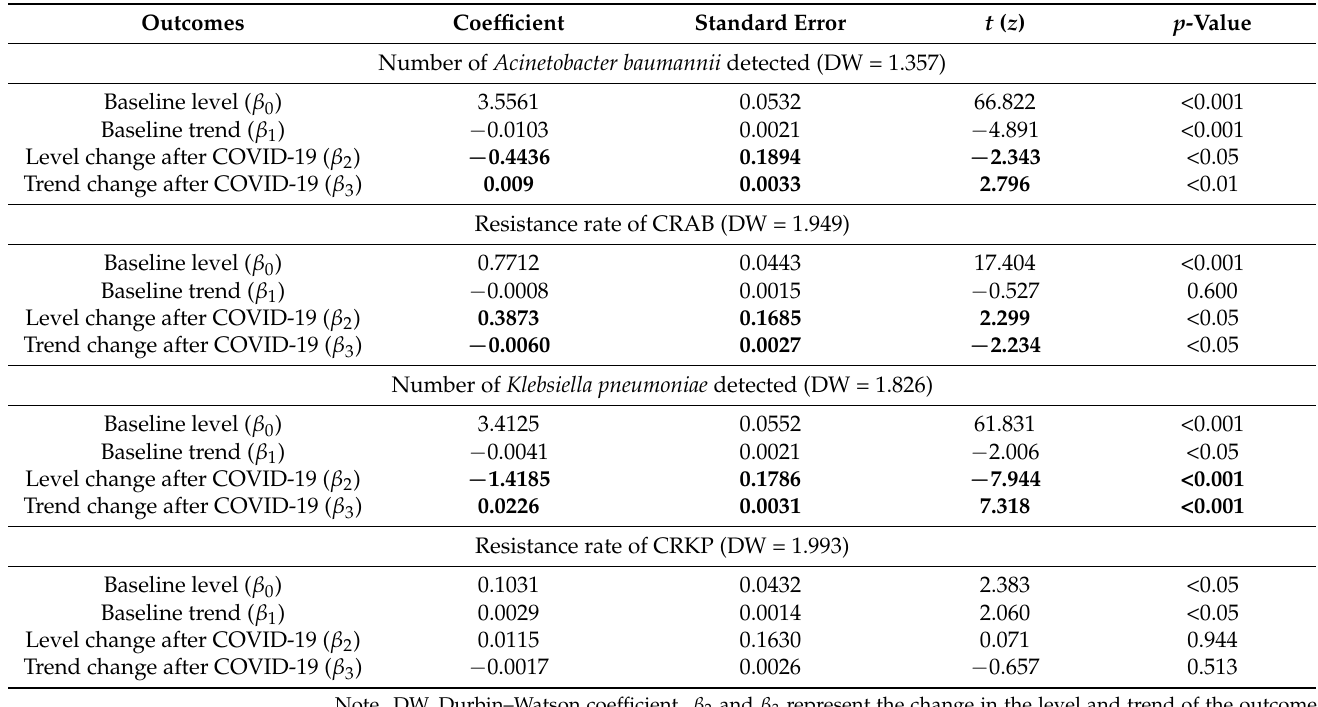
Table 2. Results of the segmented regression analysis of number of A. baumannii and K. pneumoniae and the resistance rates of CRAB and